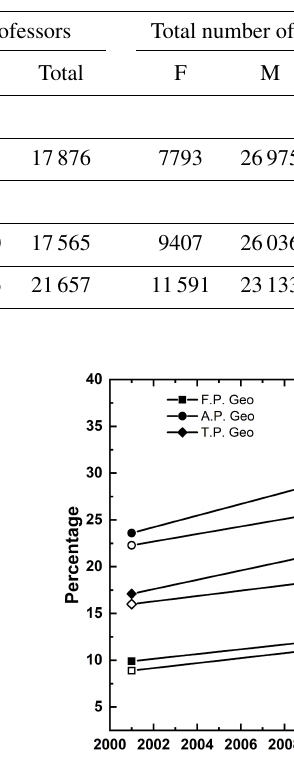
Table 7. Total number of full and associate professors and their sum for the end of 2001, end of 2009 and October 2019 in the Italian university system (data source: MIUR, https://cercauniversita.cineca.it/php5/docenti/cerca.php, last access: 31 October 2019).